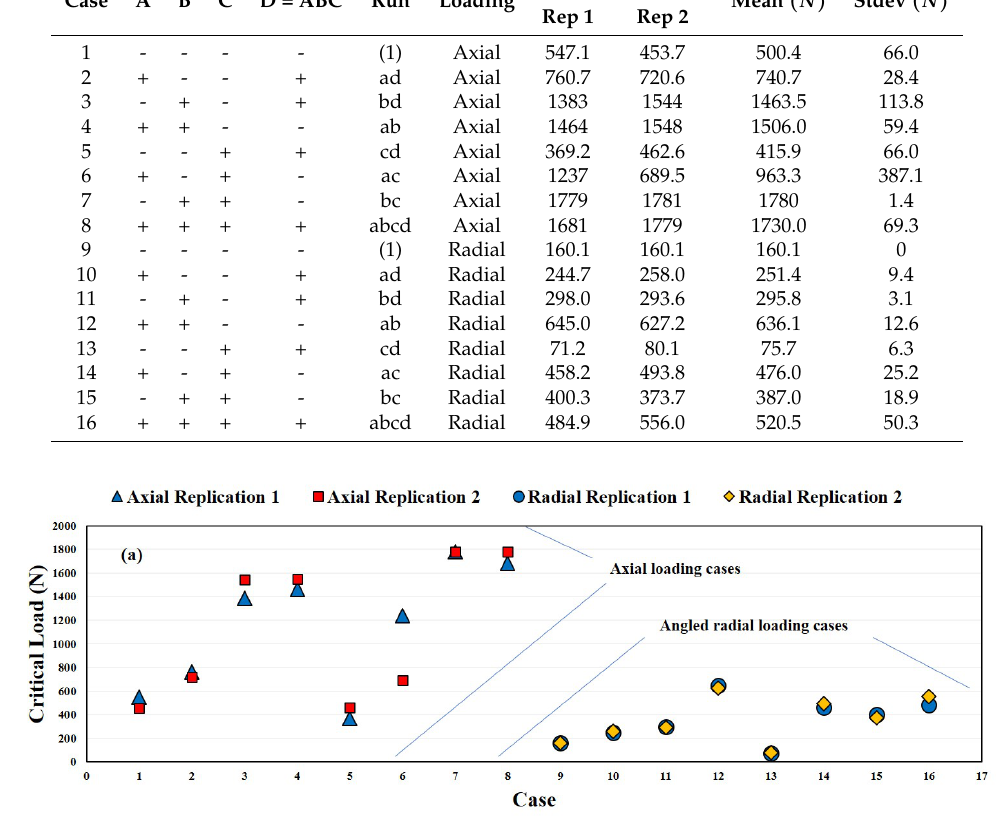
Figure 5. Experimental